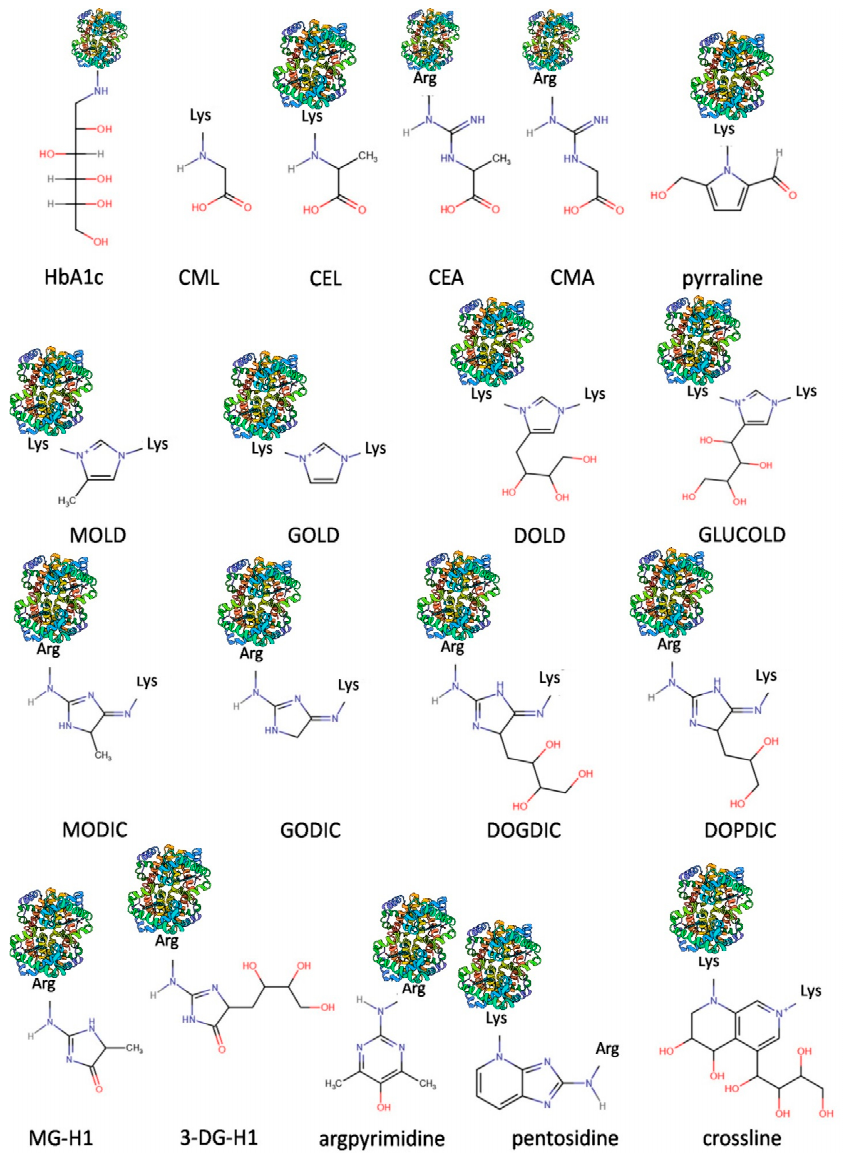
Figure 1. Different types of AGE–protein compounds. Note: Glycated hemoglobin (HbA1c), N ε –(carboxymethyl)lysine (CML), N ε -(1-carboxyethyl)lysine (CEL), N 7 –(1-carboxyethyl)arginine (CEA), N 7 –(carboxymethyl)arginine (CMA), 6-(2-formyl-5-hydroxymethyl-1-pyrrolyl)-L-norleucine (pyrraline), 6-{1-[(5S)-5-ammonio-6-oxido-6-oxohexyl]-4-methyl-imidazolium-3-yl}-L-norleucine (MOLD), 6-{1-[(5S)-5-ammonio-6-oxido-6-oxohexyl]imidazolium-3-yl}-L-norleucine (GOLD),1,3- di(N ε -lysino)-4-(2,3,4-trihydroxybutyl)-imidazolium (DOLD),1,3-bis-(5-amino-5-carboxypentyl)-4- (1,2,3,4-tetrahydroxybutyl)-3H-imidazolium (GLUCOLD), 2-ammonio-6-({2-[4-ammonio-5-oxido-5-